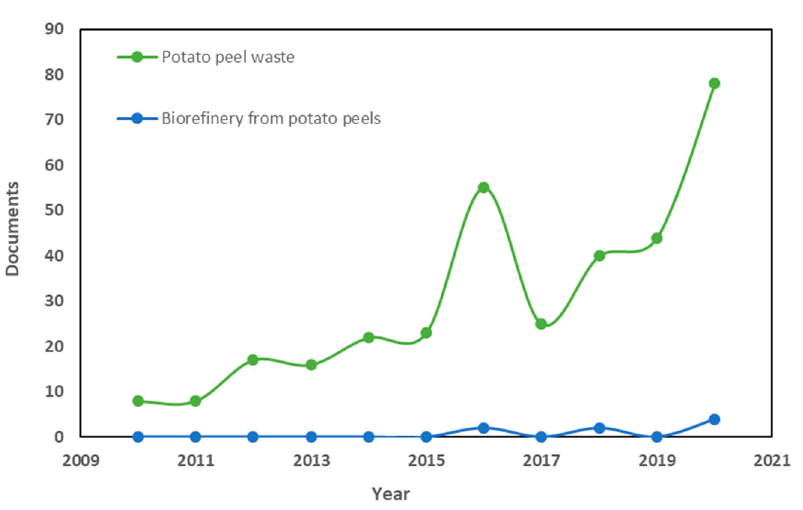
Figure 2. Research tendencies in “potato peel waste” and “biorefinery from potato peels” from 2010 to 2020. Source Scopus (3 June 2021).